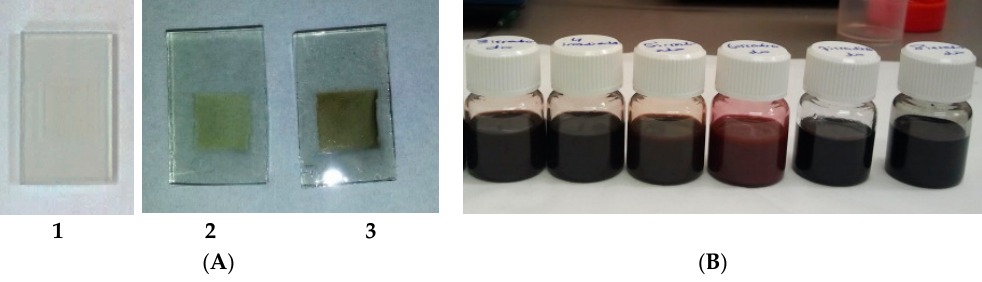
Figure 9. ( A ) 1 . TiO 2 Film; 2 . TiO 2 film sensitized using dye-CNH solution not irradiated and 3 . TiO 2 sensitized using laser irradiated dye-CNH solution and ( B ) Photograph of o -DCB suspension of dye-CNHs 1 – 6 (from left to right).